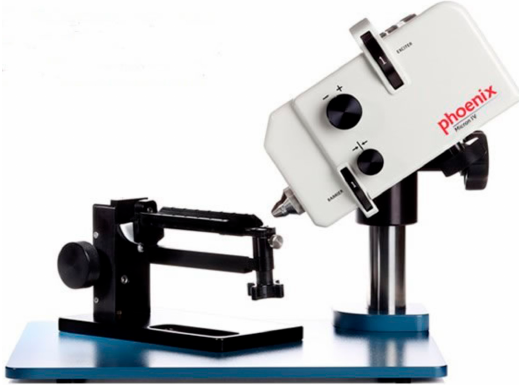
Figure 3. Physical photos of a Micron II rodent retinal imaging microscope. In the A β imaging of the brain in vitro, Ikonomovic et al. [49] recently used the FM to compare the ability of two fluorescence probes (i.e., flutemetamol and PiB) to bind to plaques. The results showed that the plaque load of flutemetamol and PiB are strongly correlated, and both of them correspond with the A β